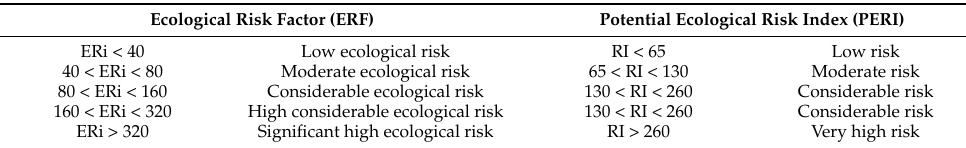
Table 2. Categories of the Ecological Risk Factor (ERF) and Potential Ecological Risk Index (PERI) according to Amuno et al.